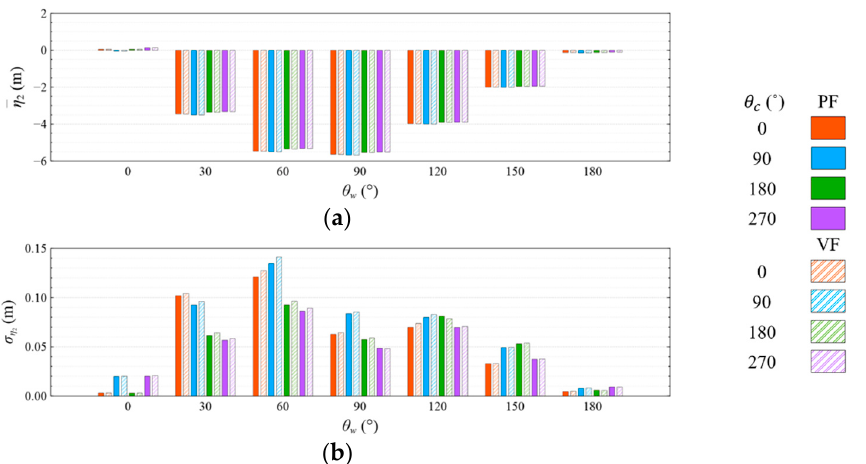
Figure 15. Comparison of ( a ) means and ( b ) standard deviations of platform sway motion under CW condition.